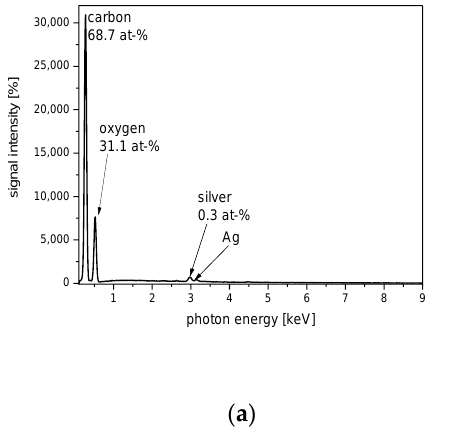
Figure 36. EDS spectra of two commercial textile products containing silver fibers: ( a ) antimicrobial sock (Go Well MED X-Static); ( b ) woven fabric for electrosmog shielding (Evolution, YShield EMR- Protection).